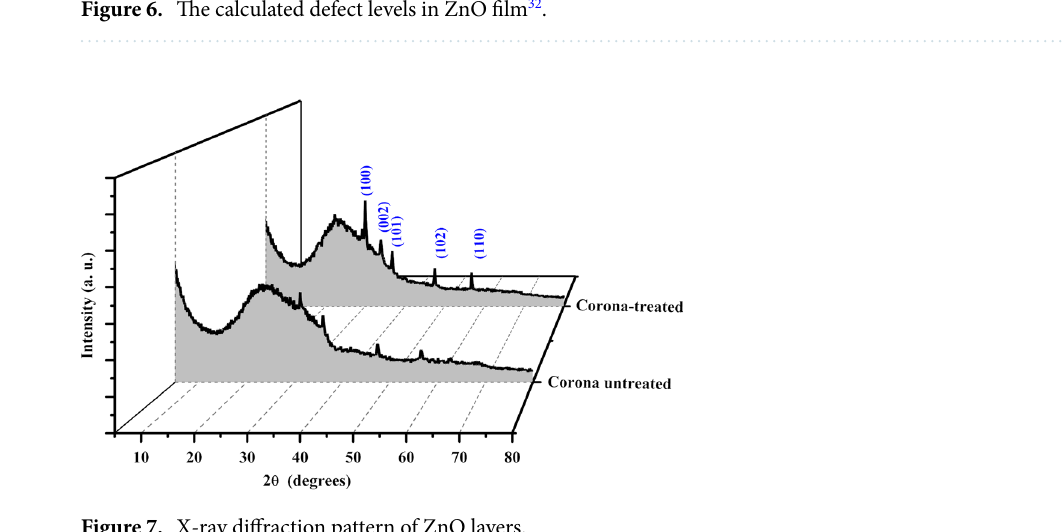
Figure 7. X-ray diffraction pattern of ZnO